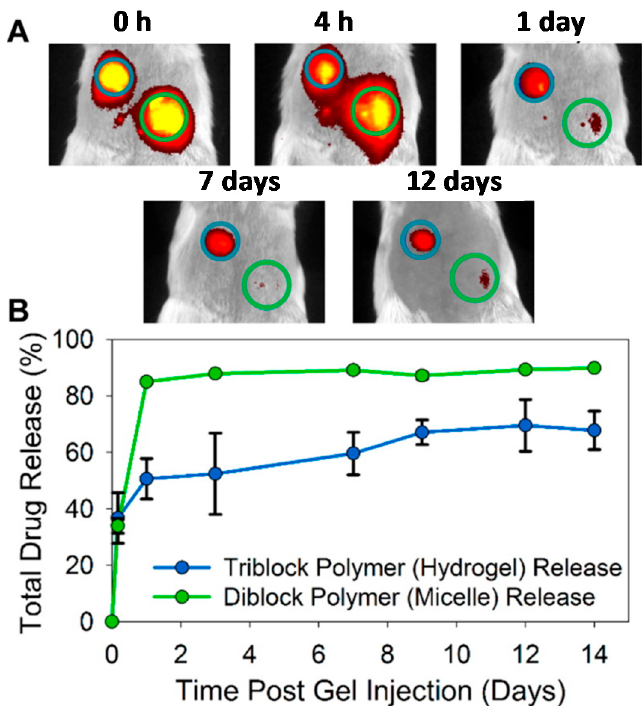
Figure 16. ( A ) Example of in vivo evolution of drug release from diblock copolymer PPS 60 - b -PDMA 150 and triblock copolymer of PPS 60 - b -PDMA 150 - b -PNIPAAm 150 injected onto BALB/c mice during 12 days; and ( B ) Quantification of drug release for both hydrogels over 14 days. Reprinted with permission from Reference [22]. Copyright © 2014 American Chemical Society.